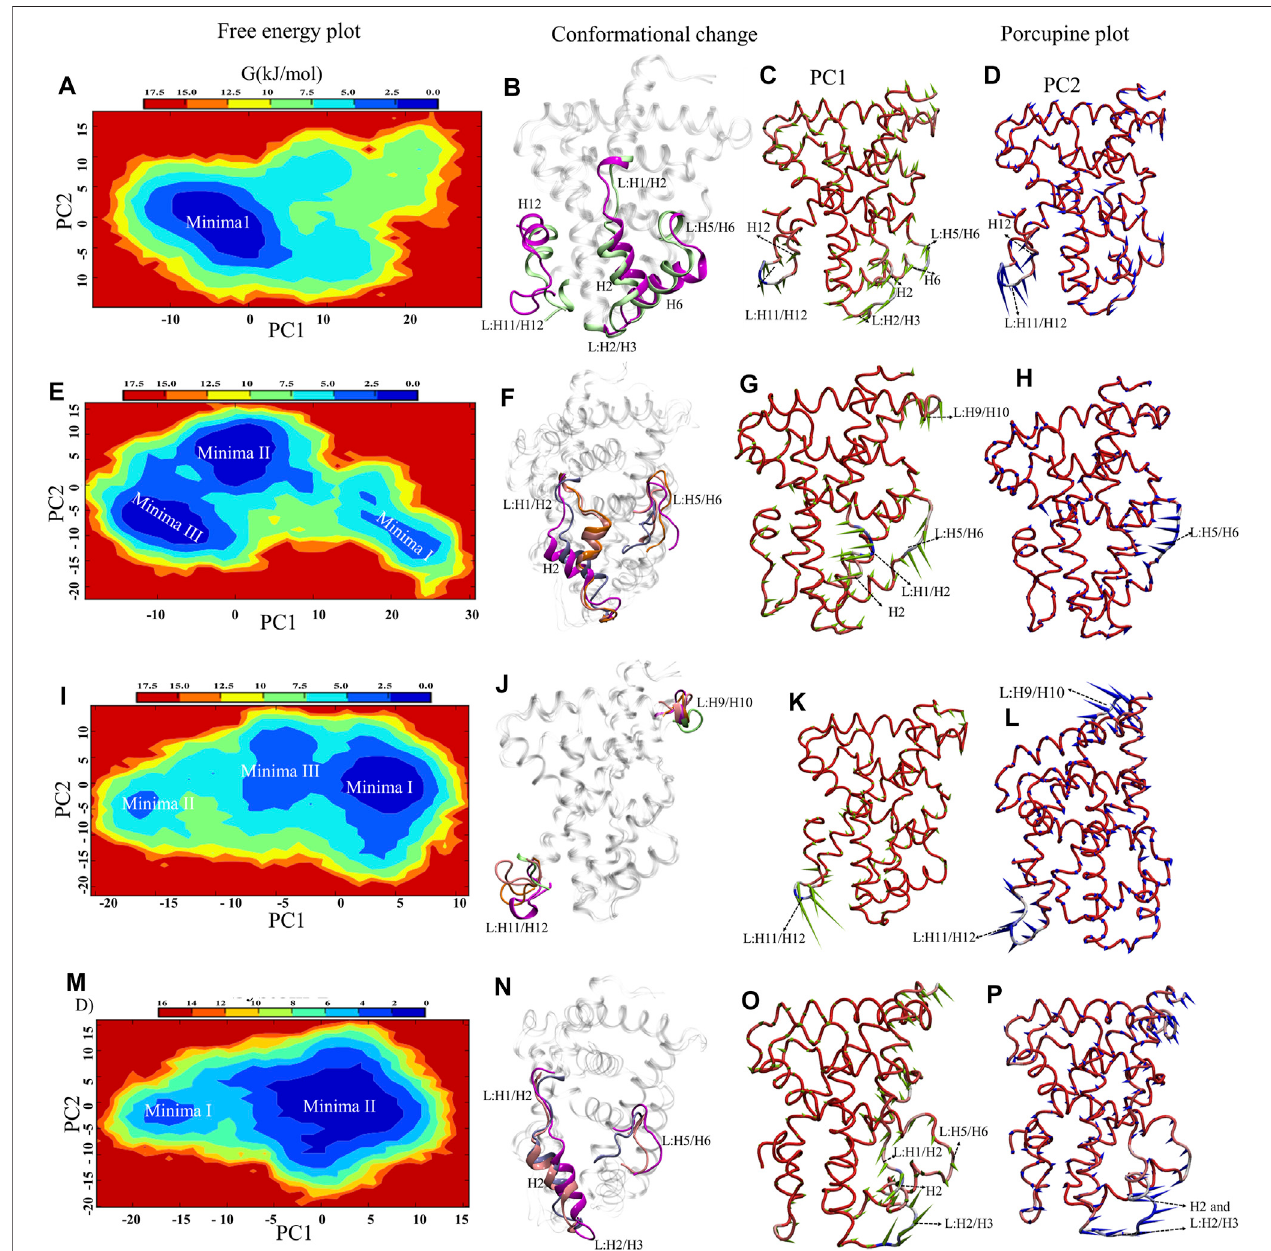
FIGURE 4 | Essential Dynamics of FXR LBD systems. The panel (A,E,I,M) show the 2D free energy plot along PC1 and PC2 for the System A, B, C, and D, respectively. The represented minima for each system depicting the signi fi cant conformational changes with respect to crystal are shown in panel (B,F,J,N) for all systems. The represented minima for each system of FXR were extracted as minima 1 (magenta), minima II (pink), minima III (orange) and compared with the crystal conformation of System C (lime) and System D (ice blue). The porcupine plots represent the principal motions along the direction of PC1 and PC2. The panel (C,G,K,O) and (D,H,L,P) described the signi fi cant motion in the different systems of FXR along PC1 and PC2, respectively. The PCA component represents the atomic fl uctuation of protein around its mean structure. The direction of motion is represented by an arrow, while the length of the arrow characterizes the movement strength. The protein isdepicted intube representation and coloured inblue – white-red, whereas red representsthe maximum C α displacement. The variations in the region were highlighted in the dotted arrow.